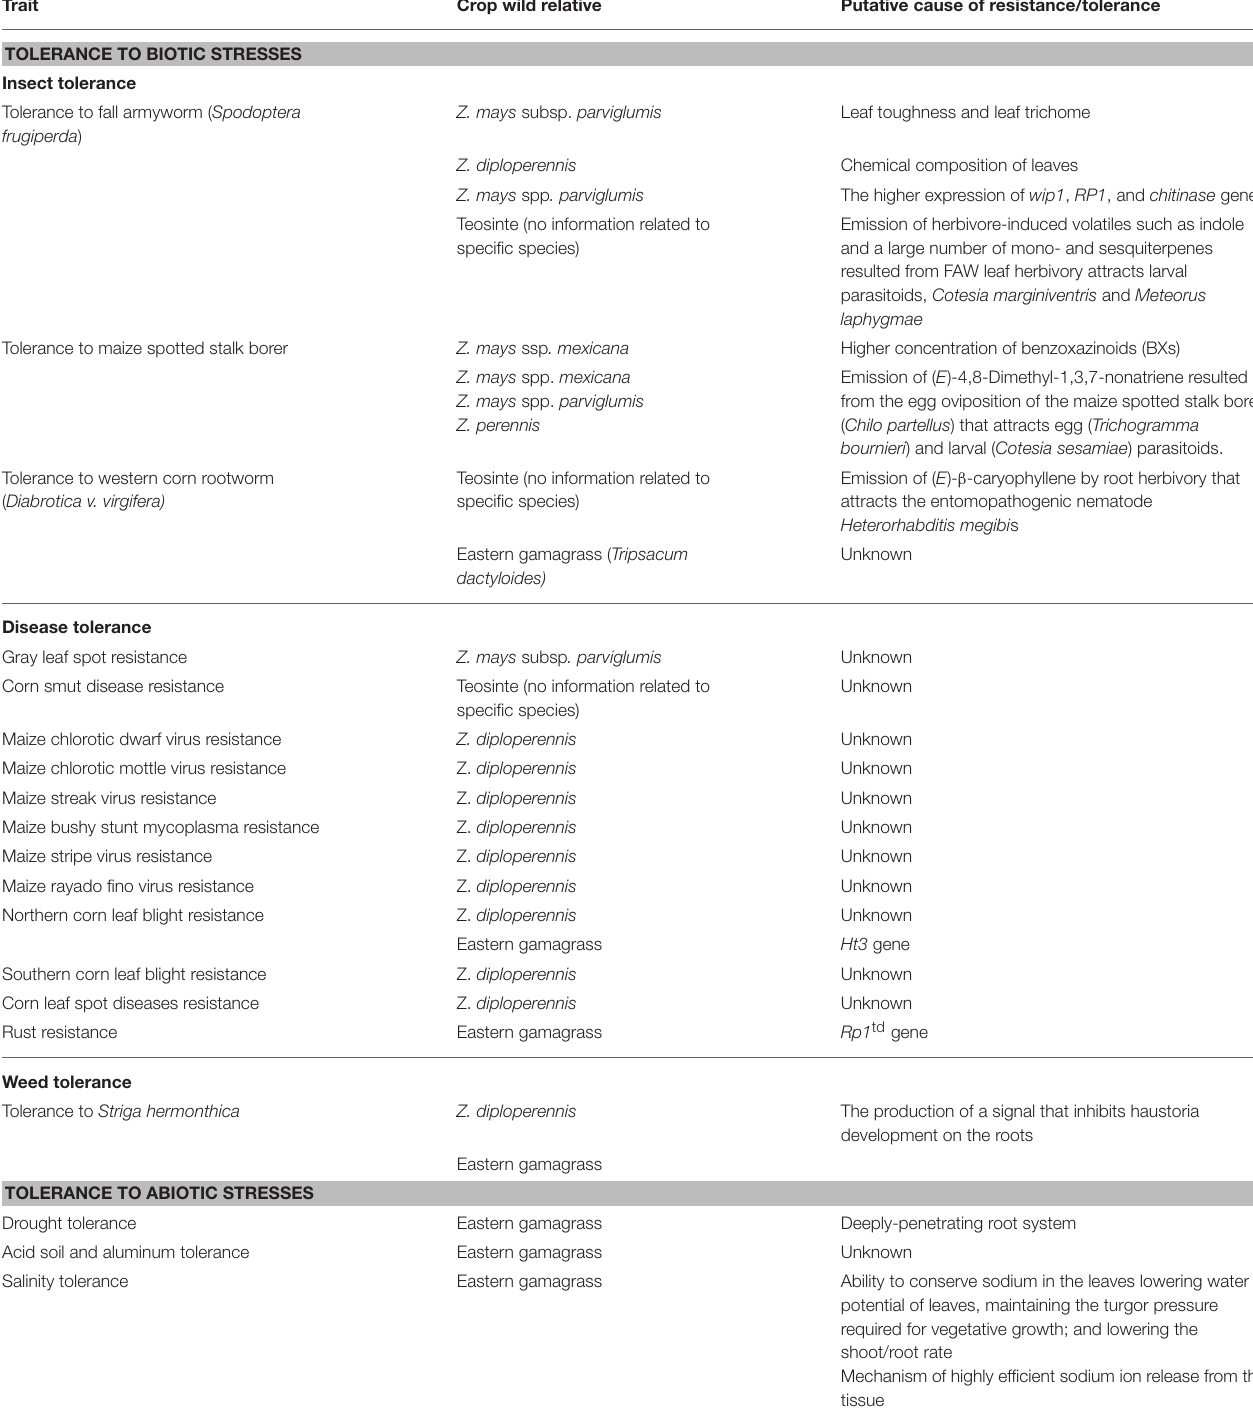
TABLE 1 | Summary of biotic and abiotic stress tolerance traits of wild relatives of maize ( Zea mays subsp. mays ).